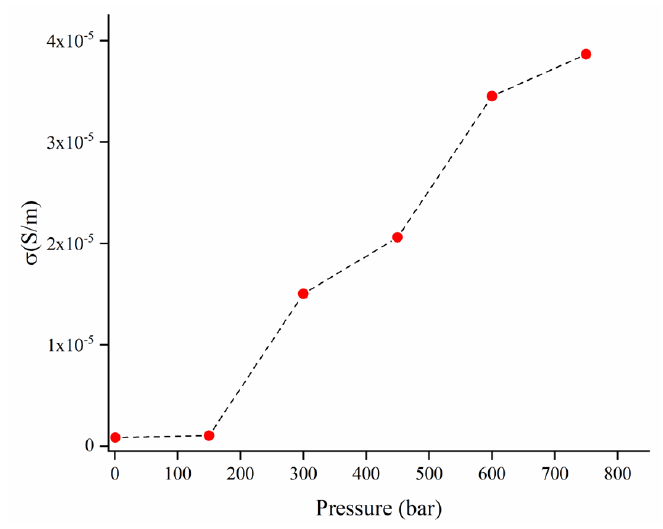
Figure 5. Conductivity of EVA/HFB 60/40 in the pressure range from 1 to 750 bar. Table 3. Comparison of maximum conductivity values achieved by using different kinds of